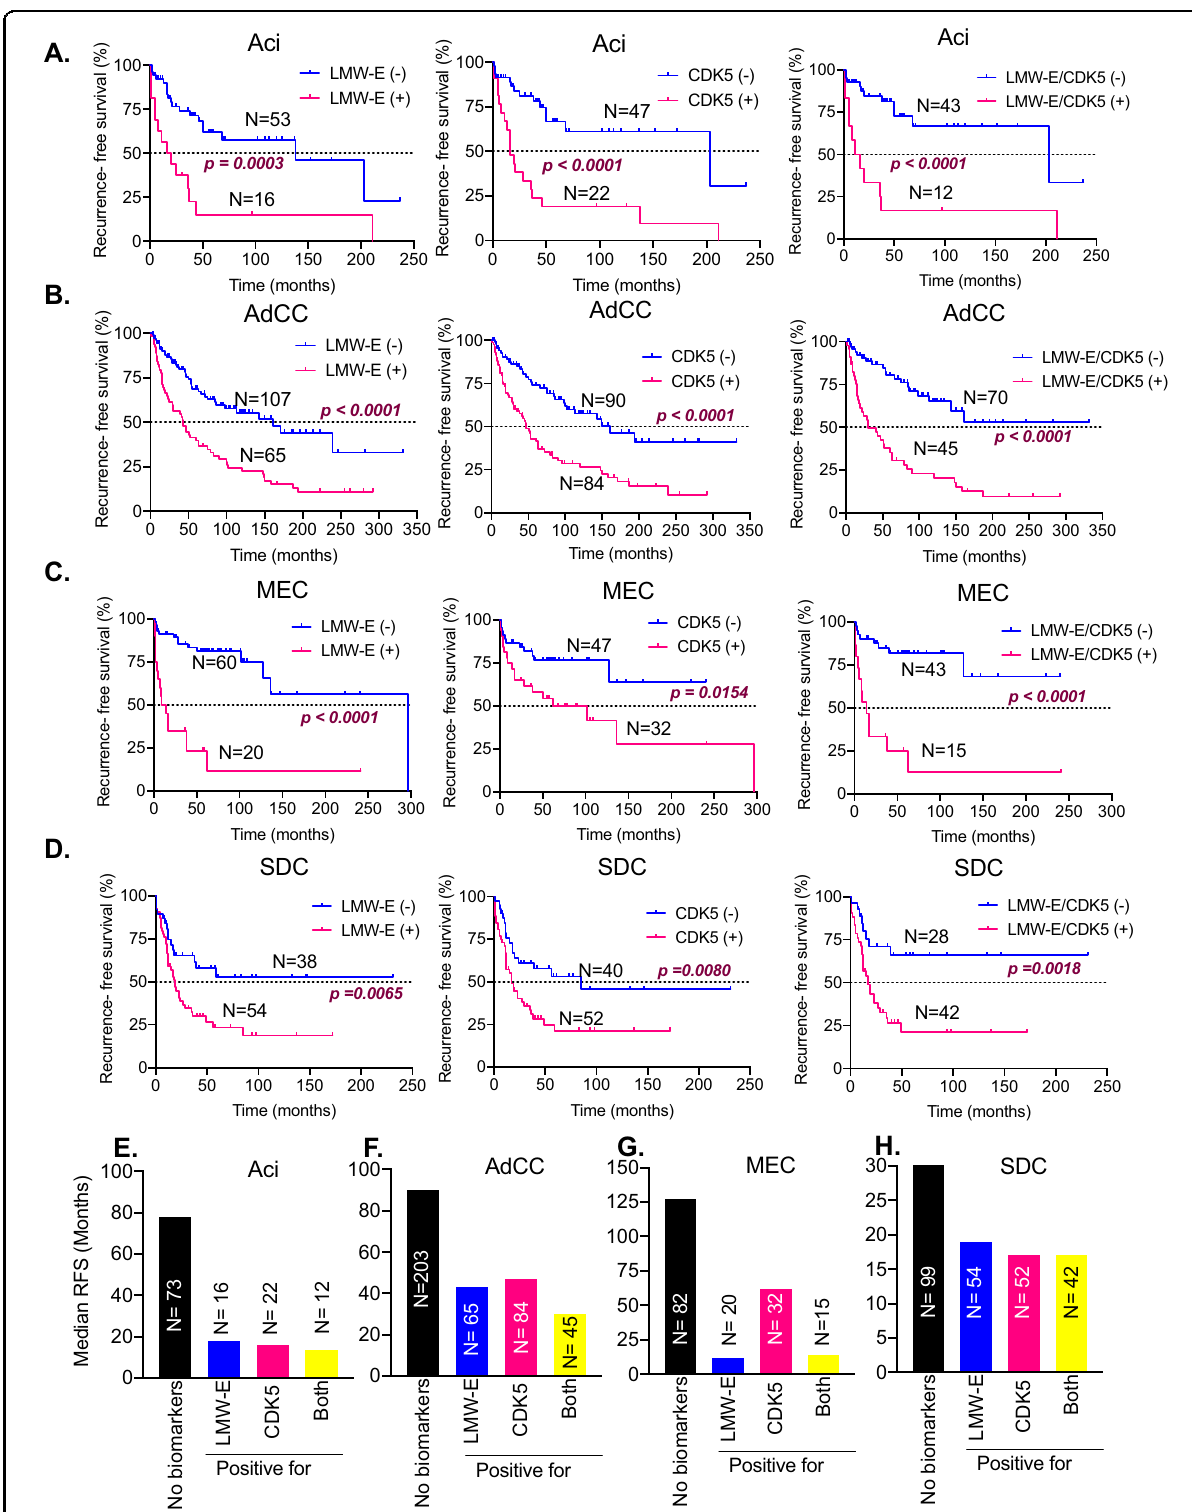
Fig. 6 High Cyclin E and CDK5 expression can predict recurrence in all subtypes of salivary gland tumors. A – D Kaplan – Meier plots for subtypes Aci, AdCC, SDC, and MEC, respectively, according to LMW-E, CDK5, or LMW-E/CDK5 expression. The expression of LMW-E and CDK5, individually and combined, were signi fi cantly associated with decreased time to recurrence in all the cohorts. p Values indicate comparison between survival curves, calculated using the log-rank (Mantel – Cox) test. E – H . Graph comparing median RFS without any biomarkers (black bars) to that when patient tumor samples are positive ( H -score = 1) for LMW-E (blue bars), CDK5 (pink bars), or LMW-E /CDK5 (yellow bars) for each